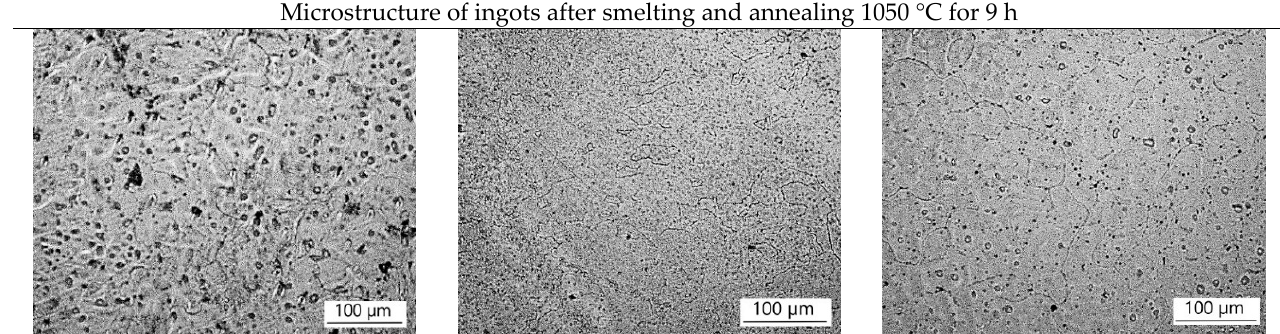
Figure 1. The effect of the method of production on the microstructure of ingots (optical microscope). After smelting, uneven structure and predominance of dendritic structure are observed on all ingots, which may indicate liquation (heterogeneity of chemical composition). After homogenization annealing at temperatures of 900 ◦ C and 950 ◦ C, the dendritic structure is preserved for 9 h. During homogenization annealing at a temperature of 1000 ◦ C, the dendritic structure is partially preserved for 9 h, but partial recrystallization of the alloy is observed. For complete recrystallization, homogenization annealing is used for 9 h at a temperature of 1050 °C, which leads to the alignment of the structure and the formation of equiaxed austenite grains with a size of ~50 microns. A further increase in temperature is impractical, due to an increase in grain, which can lead to difficulties with further plastic deformation. Also, surface images were obtained using a scanning electron microscope and spectral analysis (mapping) was carried out (Figure 2).